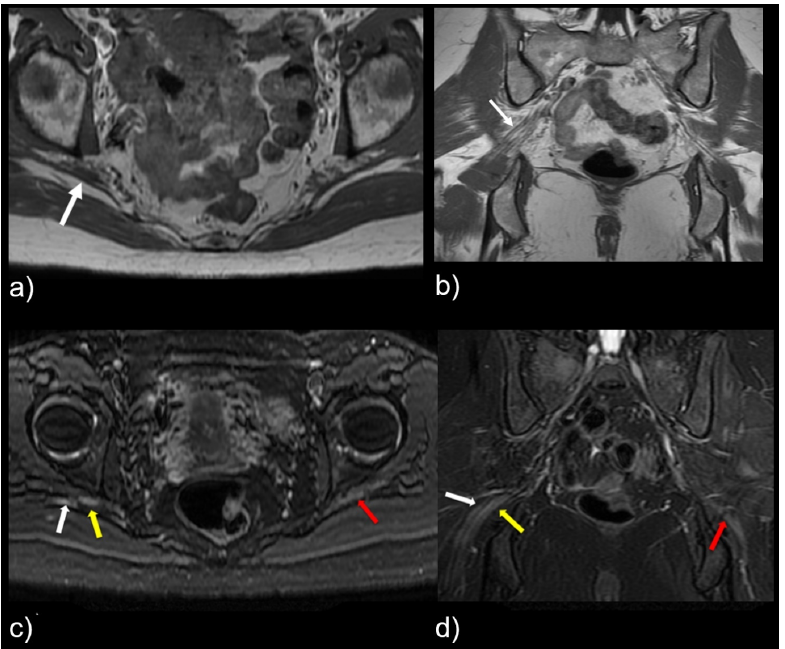
Figure 4. Patient with a symptomatic type II variant and a split right sciatic nerve. Axial ( a ) coronal ( b ) T1-weighted sequence, showing the two components of the split sciatic nerve (white arrow). Axial ( c ) and coronal ( d ) T2-weighted IDEAL sequences demonstrate the split sciatic nerve, with the common peroneal (white arrow) and the tibial (yellow arrow) nerve components seen distinctively. There is also increased nerve caliber and increased nerve T2 signal involving the split right sciatic nerve, relative to the normal caliber and T2 signal of the left sciatic nerve (red arrow).